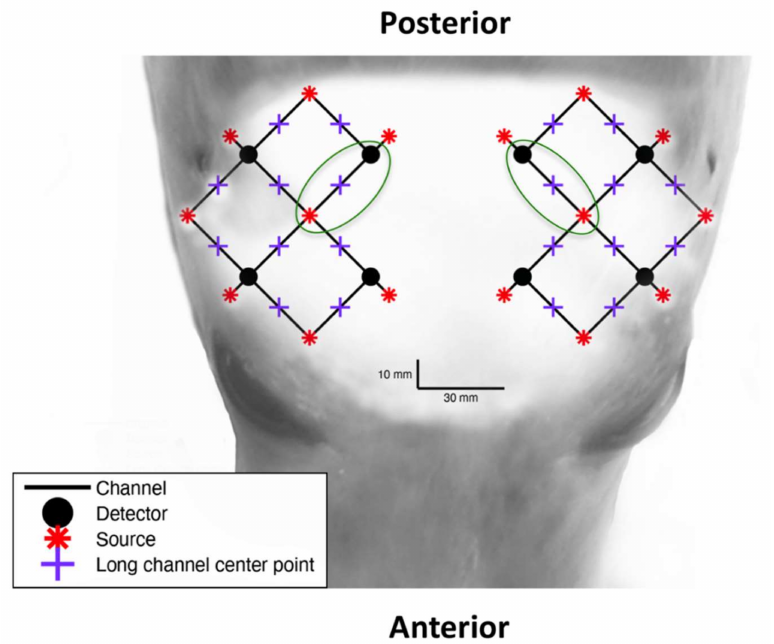
Figure 1. The optode array configuration overlaid on the head of a juvenile grey seal for anatomical perspective of the light emitter (red points) and detector (black points) locations. Black lines indicate each of twenty 3 cm optode-detector distance channels and green circles indicate the two channels that were chosen for analysis, which are found between the parietal and pre-frontal